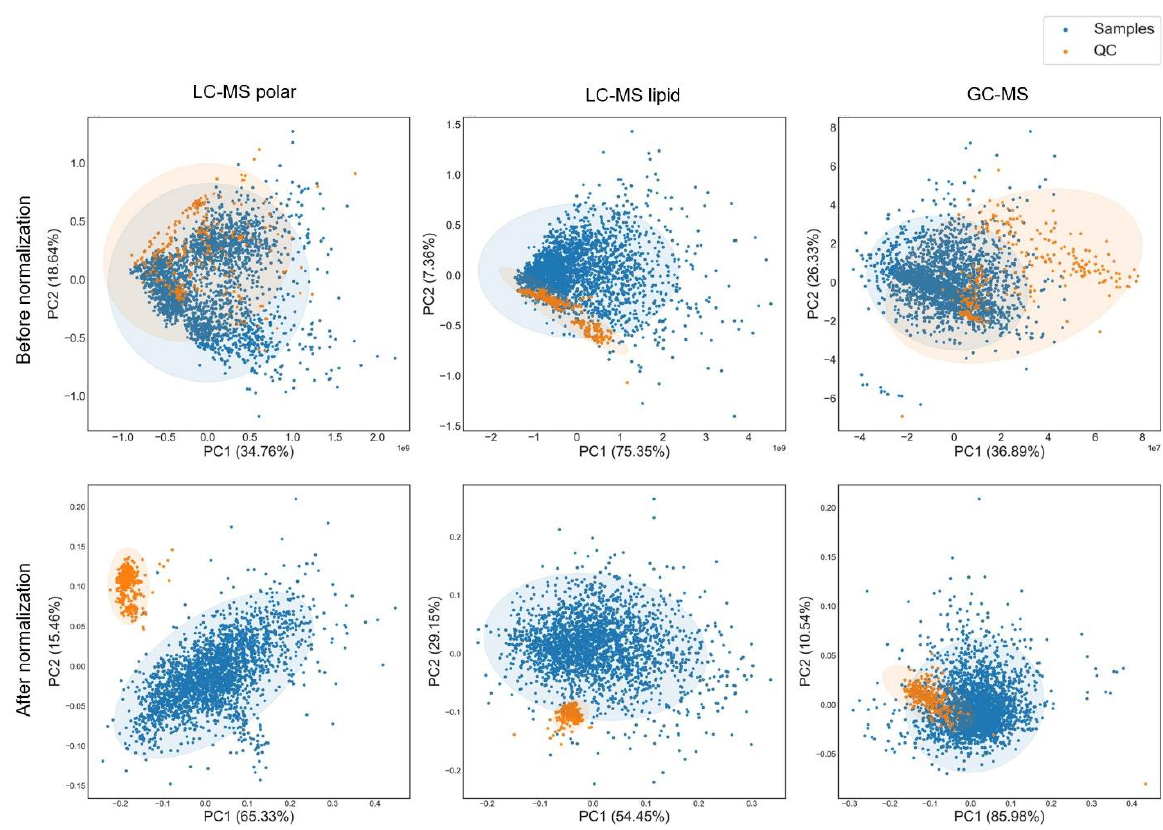
Figure 5. The normalization performance of NormAE. The PCA plots show the normalization performance of the NormAE method [24]. Orange dots: QCNIST; blue dots: biological samples.